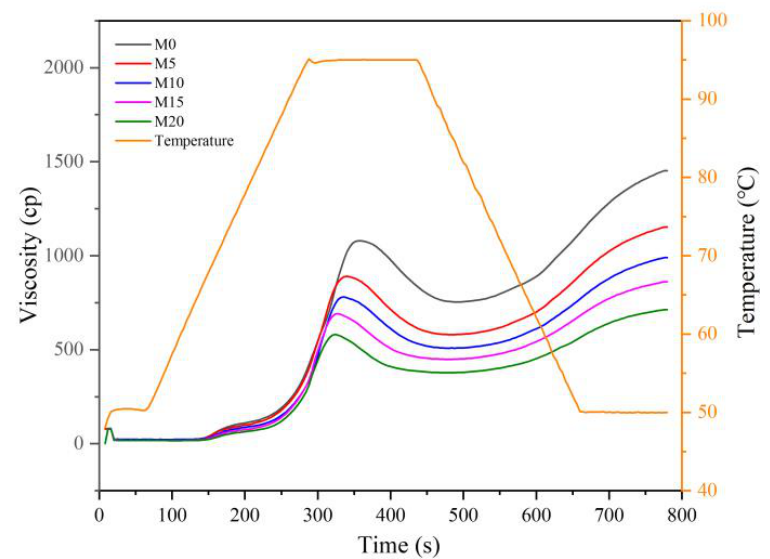
Figure 1. Rapid Visco Analyzer (RVA) curves of high-gluten wheat flour formulated with 0% (M0), 5% (M5), 10% (M10), 15% (M15), and 20% (M20) mealworm powder. Table 2. Pasting characteristics of high-gluten wheat flour with 0% (M0), 5% (M5), 10% (M10), 15% (M15), and 20% (M20) mealworm powder substitution levels. Trough Breakdown Final Viscosity Viscosity (cp) Viscosity (cp)